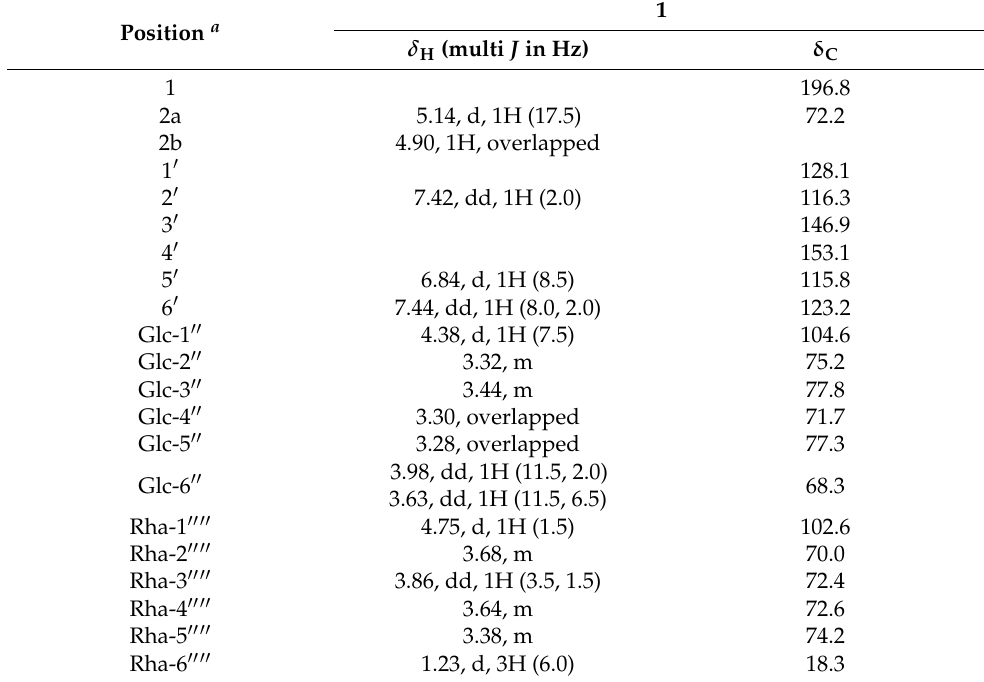
Figure 2. Structures of compounds 1 – 22 isolated from the fruits of M. alba . Table 2. 1 H and 13 C NMR spectroscopic data of compound 1 ( δ in ppm, methanol- d 4 , 500 and 125 MHz).